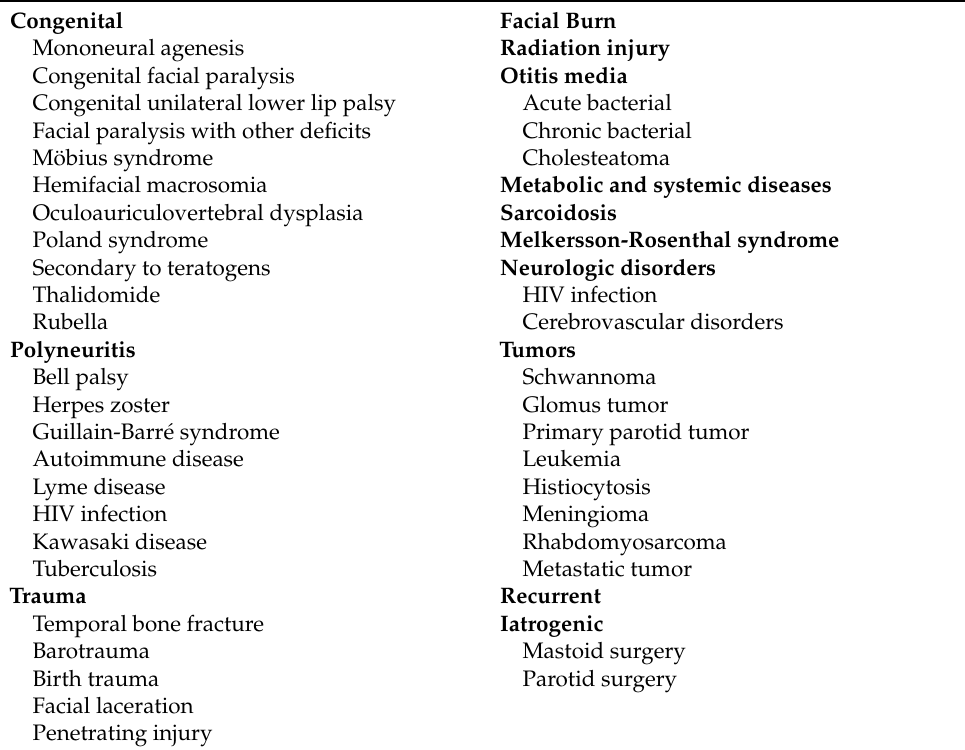
Table 1. Etiology of facial